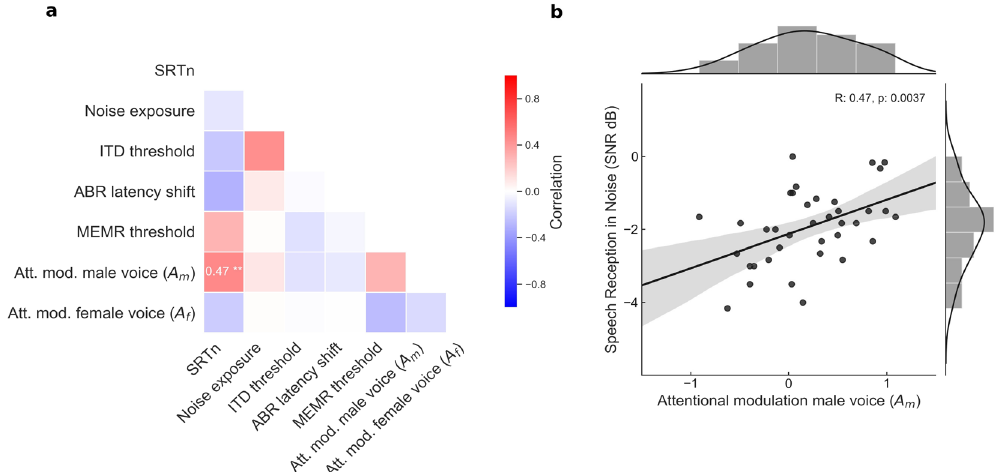
Figure 4. Relation between speech-in-noise perception and the attentional modulation of the brainstem response. ( a ) The only significant pairwise correlation, after correcting for multiple comparisons (FDR; q = 0.1), arises between the SRTn and the attentional modulation of the brainstem response to the male voice, A M . There is no significant correlation between the SRTn and noise exposure, or between any of the other auditory measures. ( b ) The attentional modulation A M can explain 22% of the variation in the speech-in-noise comprehension. The p- value (0.0037) remains significant after correcting for multiple